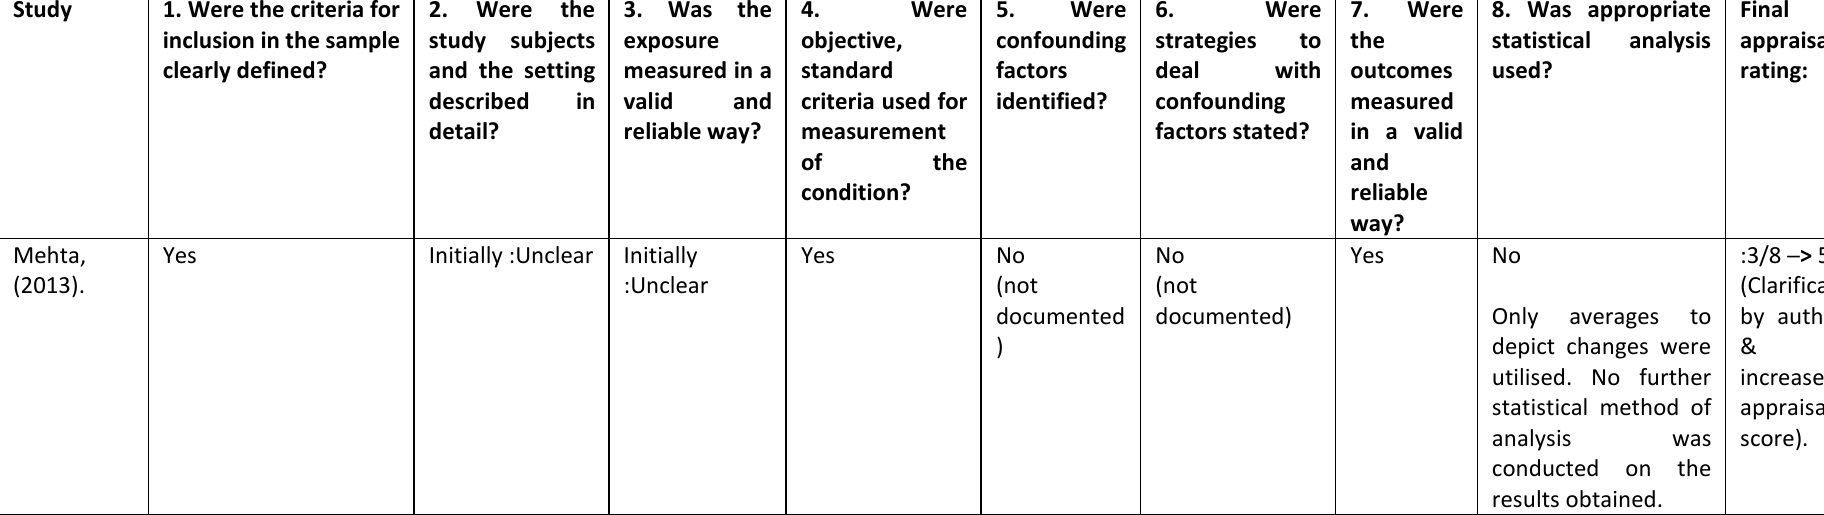
TABLE 7-A1: Analytical cross sectional study detailed appraisal. Study 1. Were the criteria